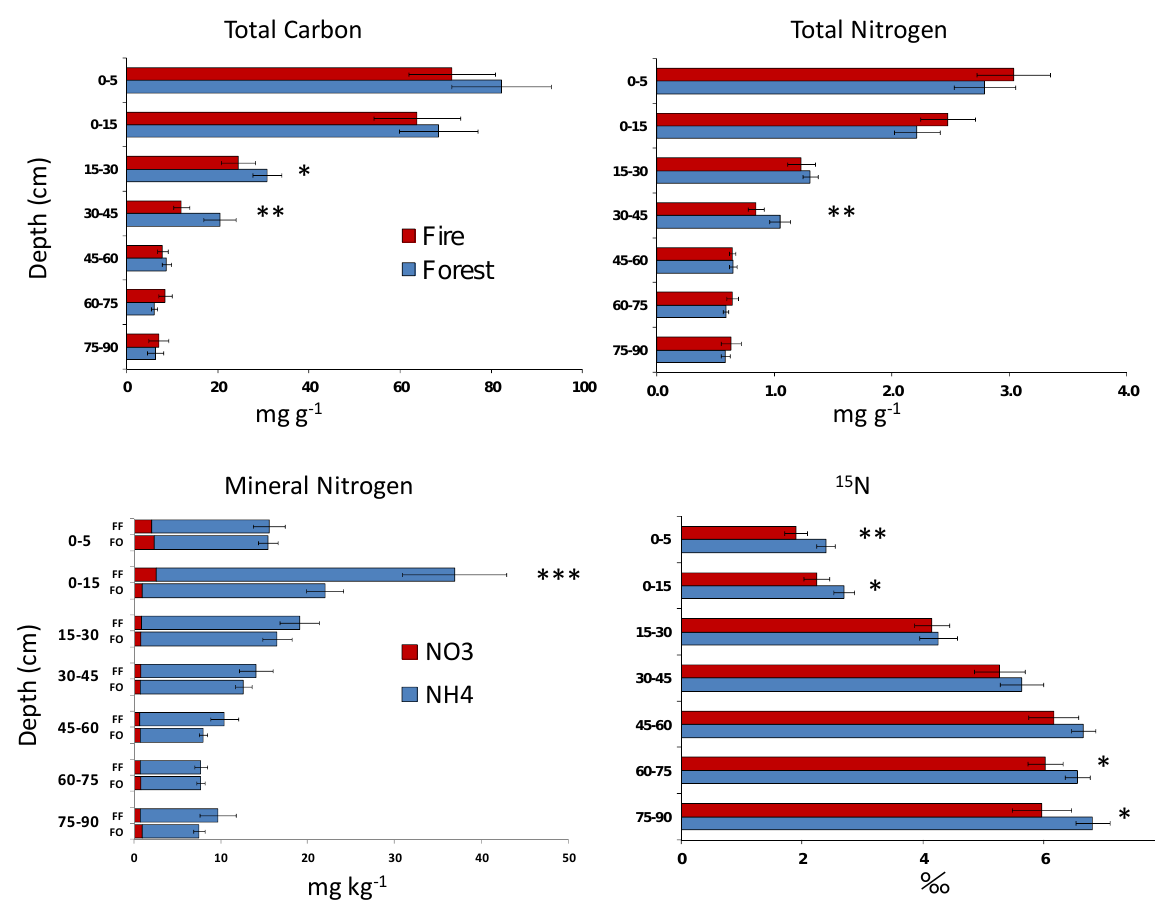
Figure 1. Total C, total N, mineral N, and 15 N in the Sagehen soils. *, ** and *** indicate statistically significant differences, student’s t -test on log transformed data. Standard errors are